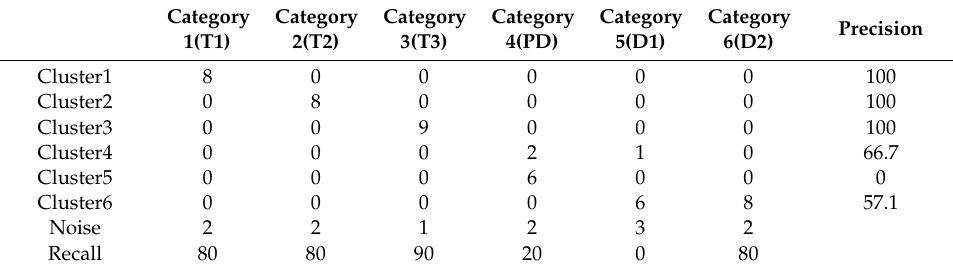
Table 3. Confusion matrix of DBSCAN analysis